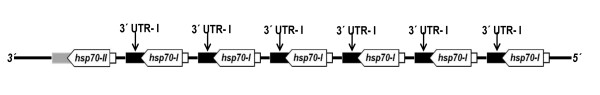
Graphical representation of the 3' UTR-I position in the HSP70 cluster of L. braziliensis.